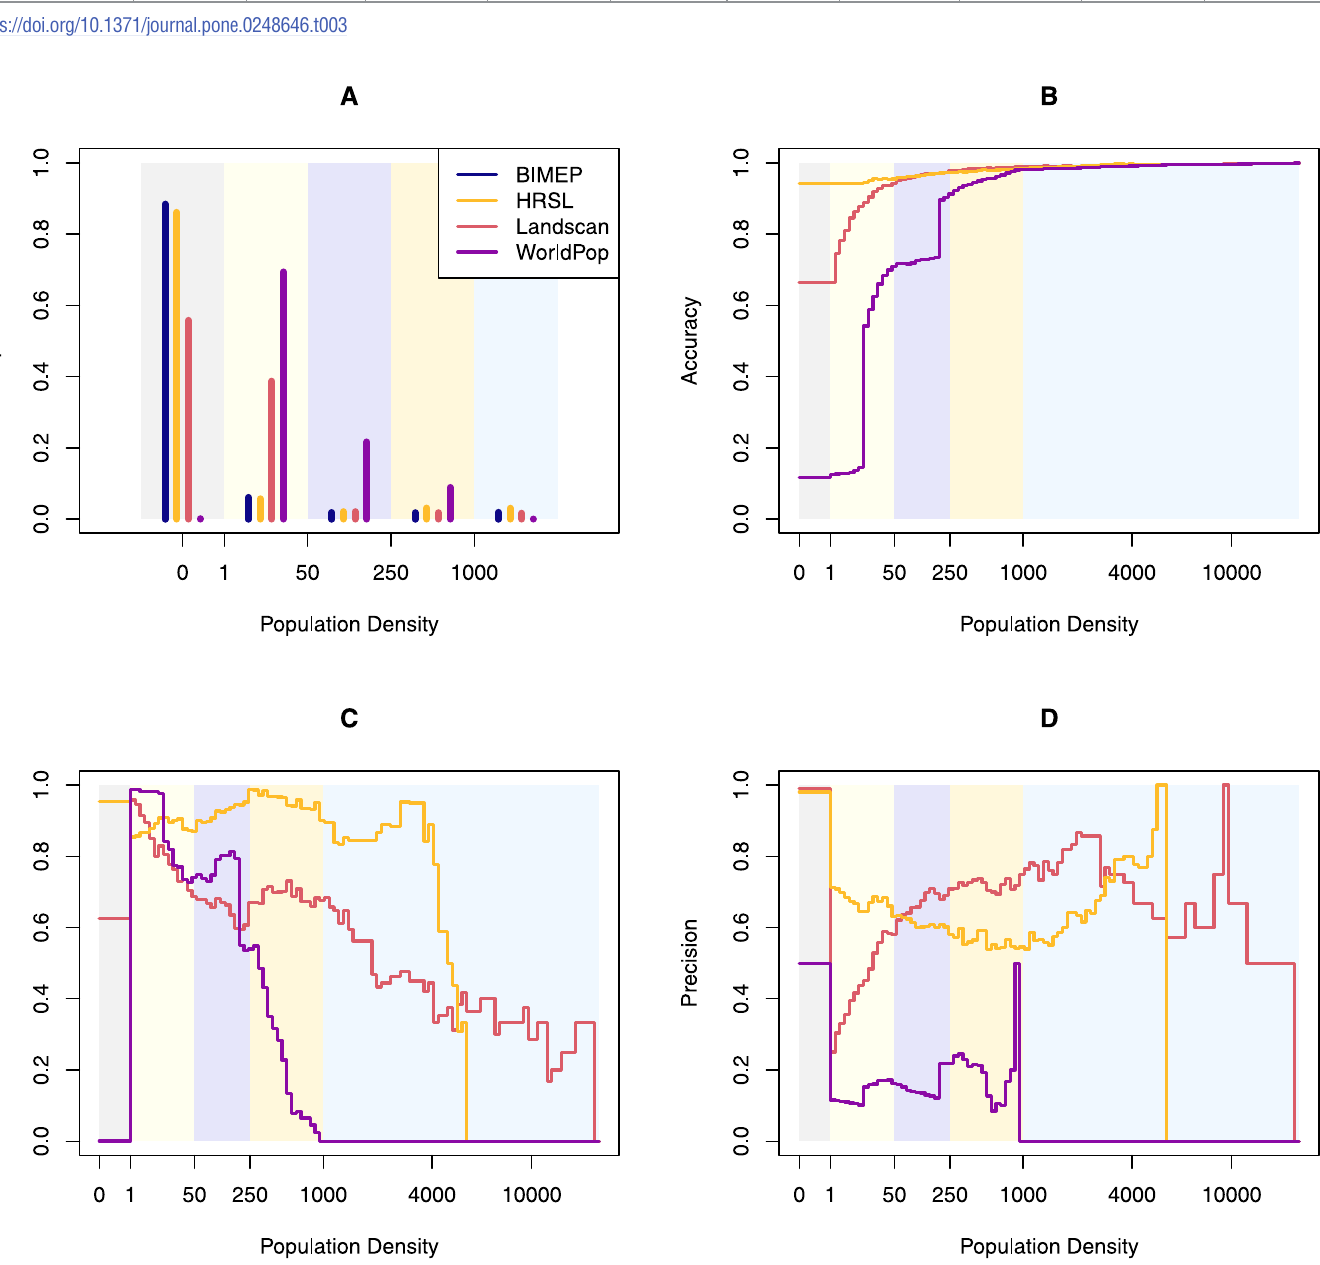
Fig 6. A) The proportion of the population in density categories defined by breakpoints of 1, 50, 250, and 1,000 people. B) The accuracy profile; C) The recall profile; D) The precision